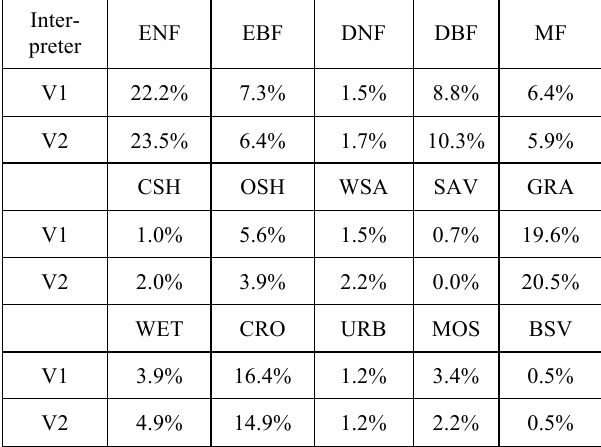
Table 1. The percentage distribution of IGBP classes labeled by two